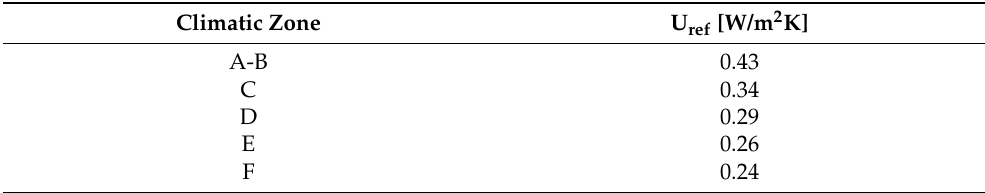
Table 4. Reference value for thermal transmittance of vertical opaque structures, to the exterior, and unheated spaces or against the ground